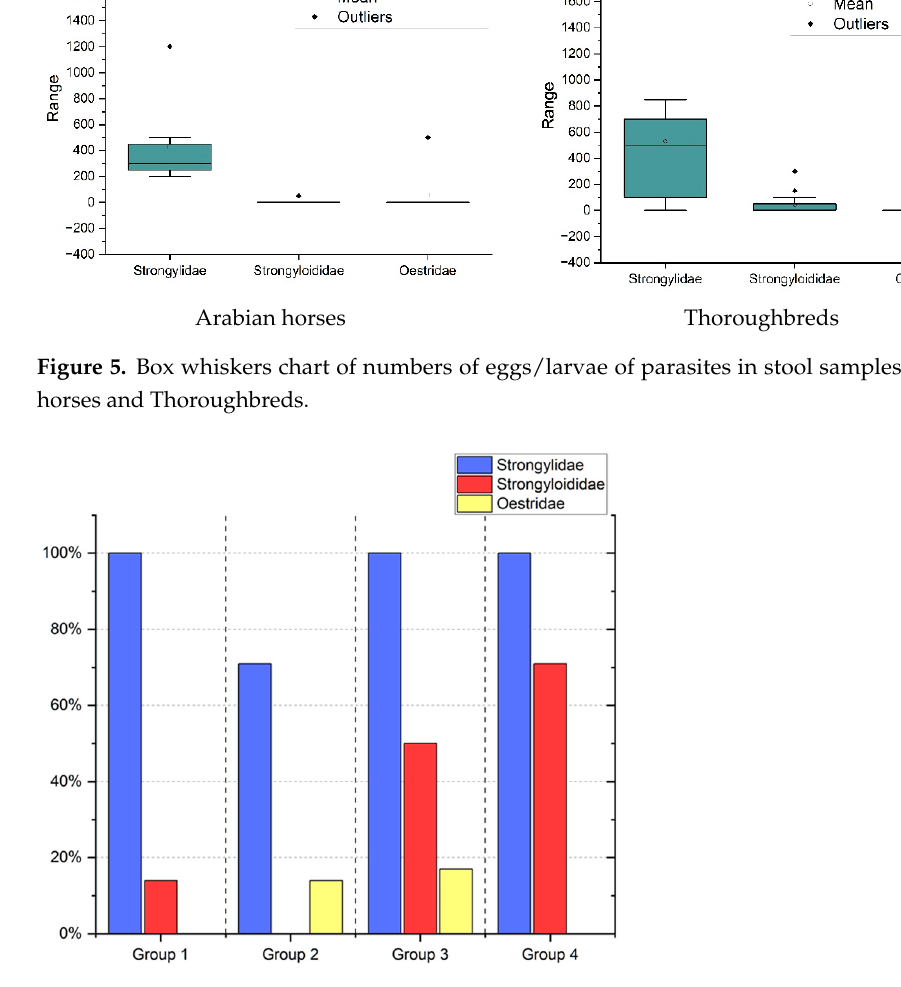
Figure 6. Prevalence of parasites in the experimental groups (group 1—supplemented with soybean oil, group 2—supplemented with linseed oil, group 3—supplemented with linseed oil and vitamin E, group 4—control group).